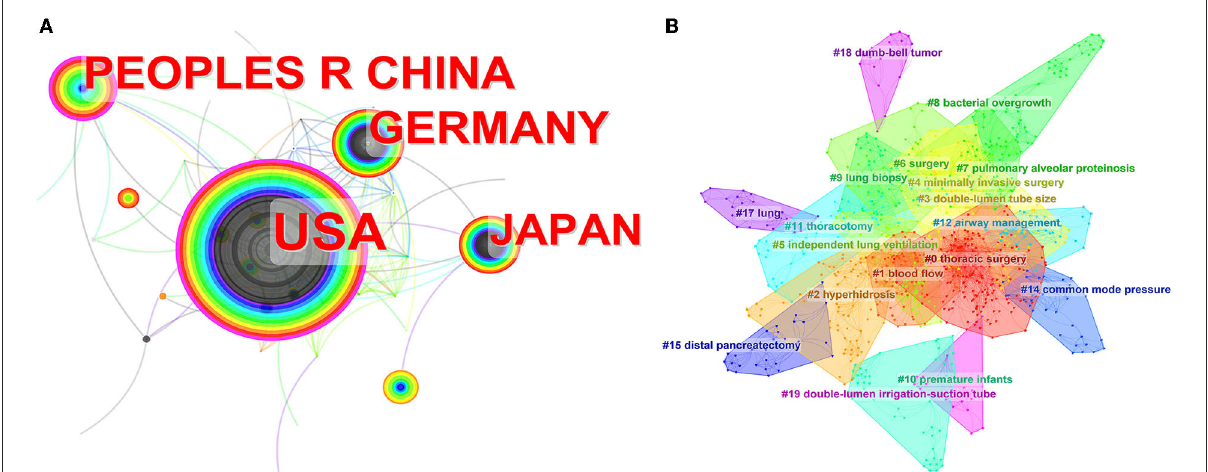
FIGURE1 (A) The network map of collaborating countries in DLT research. Annular size, reflecting the number of publications; purple circle size, reflecting the intensity of centrality (generally considered to be meaningful when > 0.1), and centrality is reflecting the degree to which a node is connected to other nodes throughout the network. (B) The clustered network map of keywords on DLT